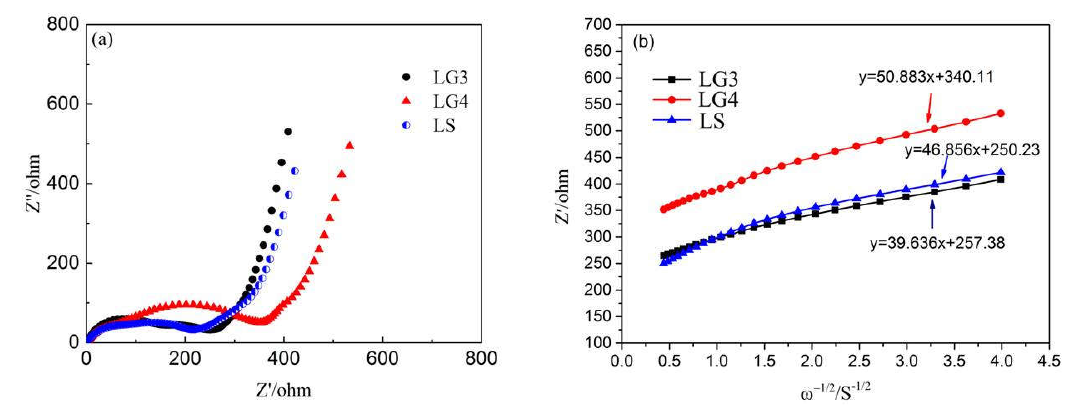
Table 5. Charge transfer resistance (Rct), Warburg factor (σ) and lithium ions diffusion coefficient (D Li ) of the assembled lithium